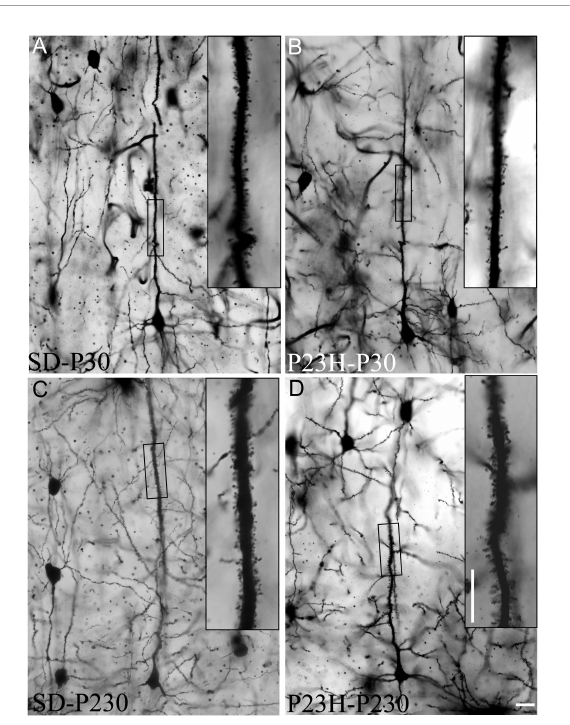
FIGURE7 Golgi-stained sections from the primary visual cortices of the SD and P23H rats at P30 and P230. (A–D) The low-magnification image shows examples of the layer V pyramidal neurons selected for the quantitative evaluation of dendritic spines. Insets show dendritic spines from representative apical shaft segments. Scale bar: 10 µ